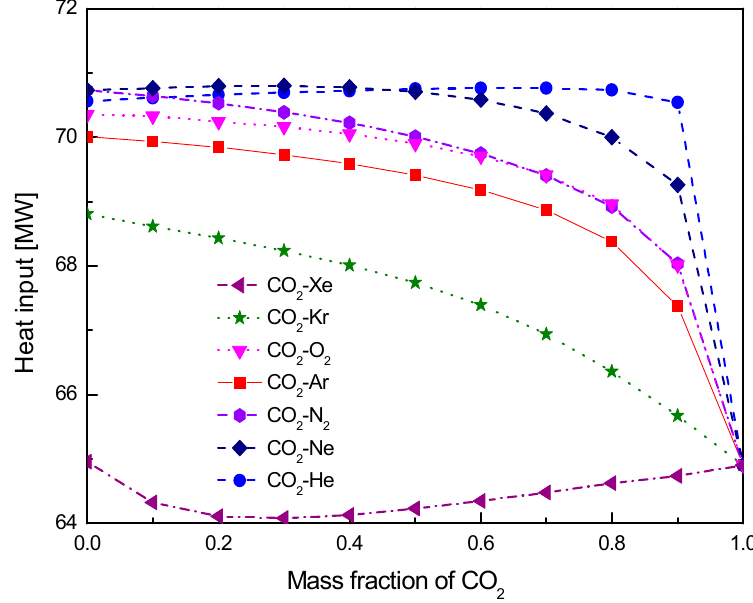
ff erent mass fractions of CO